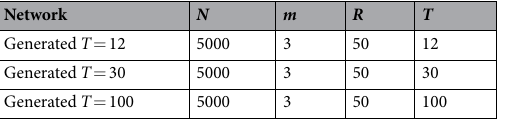
Table 1. Simulation settings.